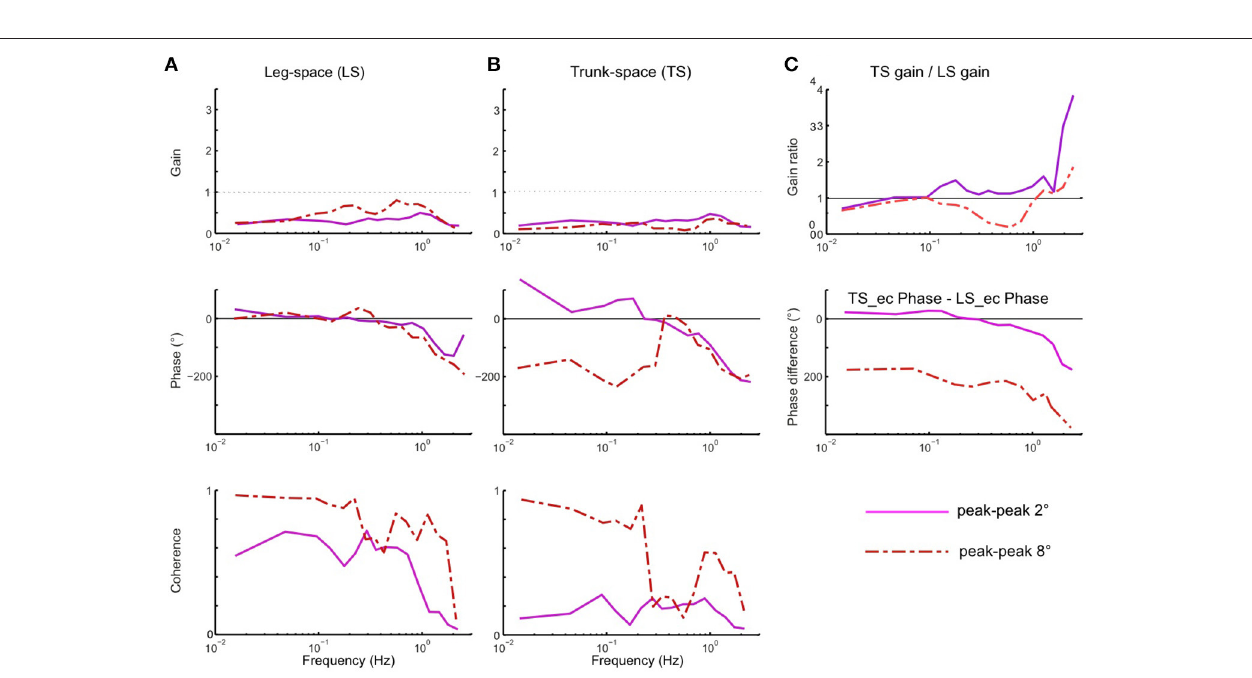
FIGURE 9 | Time series of stimulus and sway responses of the robot to support surface tilt ( A , with vestibular function; leg-in-space tilt, LS, and trunk-in-space tilt, TS, in space coordinates) and support surface translation ( B , without vestibular function; leg-in-space tilt, LS, and trunk-in-space tilt, TS, in platform coordinates) using the PRTS stimulus